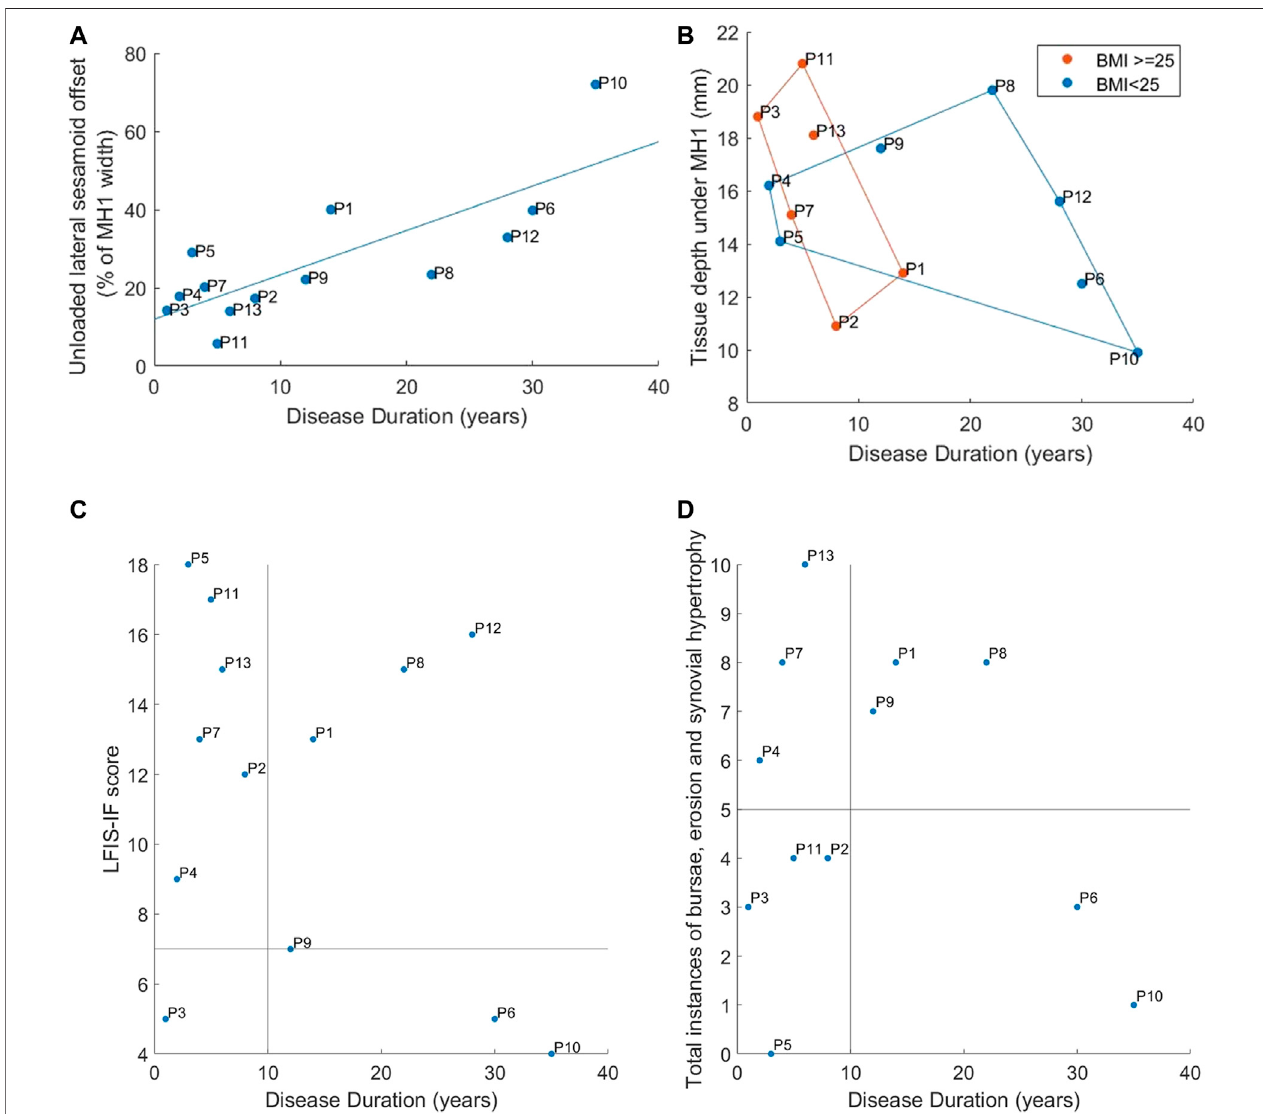
FIGURE 4 | Correspondence of disease duration to: (A) Lateral offset of the sesamoid bones (B) Tissue depth under MH1 with groupings for normal vs high BMI using markercolorsandconvexhullboundaries (C) LFIS-IF scorewithquadrantsindicatingshortvslongdurationand lowvsmoderate/high LFISscore (D) Instancesof bursae,erosionandsynovialhypertrophyattheMTPjoints,withquadrantsshowingshortvslongdurationandlowvshighinstances.Note:dataforP12wasmissingfor instances of bursae, erosion and hypertrophy and so n (cid:2) 12.